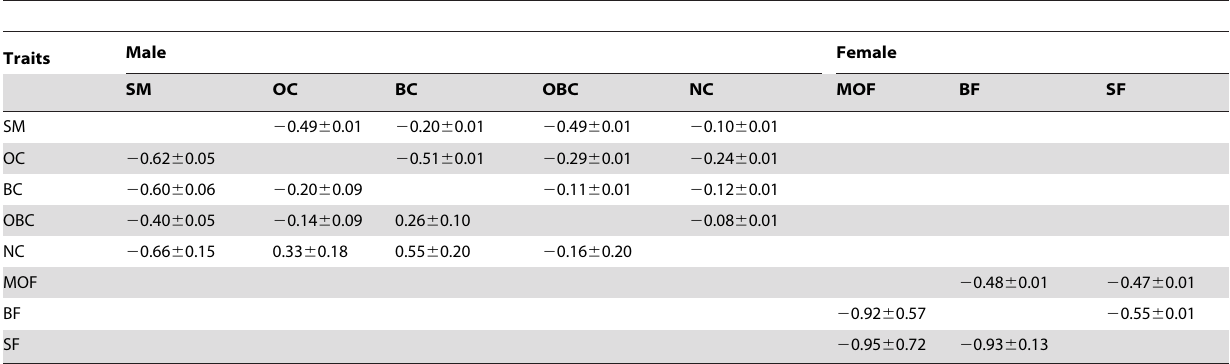
Table 4. Phenotypic (above) and genetic (below the diagonal) correlations ( 6 s.e.) among male morphotypes and female reproductive statuses.